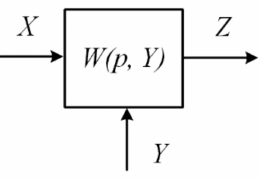
Figure 13. Scheme of a nonlinear structure.